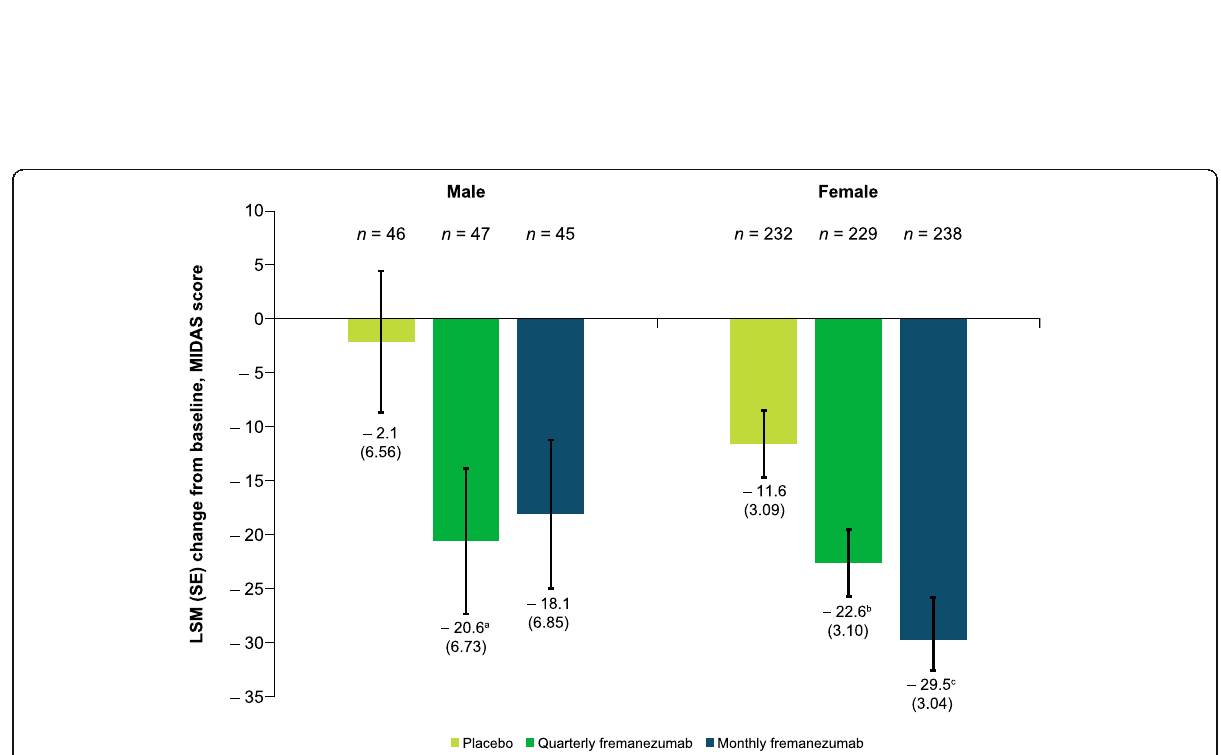
Fig. 6 Change in MIDAS scores at 12 weeks by sex. MIDAS, Migraine Disability Assessment; LSM, least-squares mean; SE, standard error. a P = 0.023 vs placebo. b P = 0.004 vs placebo. c P < 0.001 vs